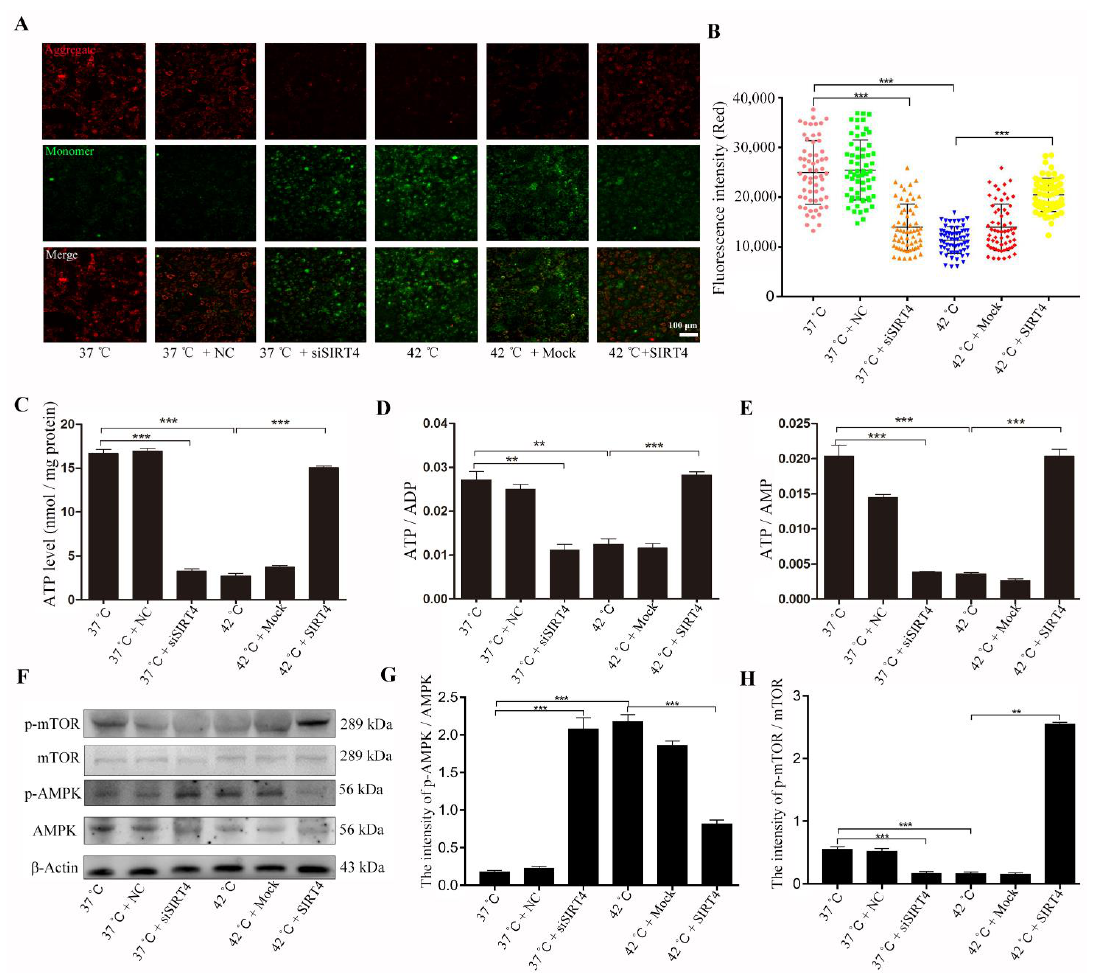
Figure 4. SIRT4 protects BMECs from heat stress-induced cell damage through the